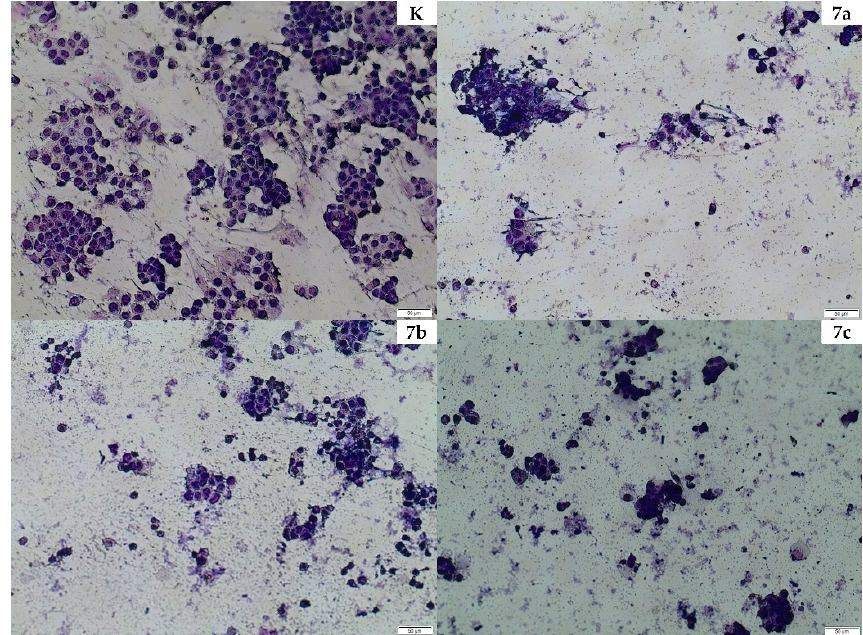
Figure 4. Presentation of the effect of PAL4 extract on morphology and cell count of the HT-29 line. Images were taken using an Olympus BX51 light microscope. K—control, 7a—25 μ g/mL, 7b—75 μ g/mL, and 7c—125 μ g/mL.